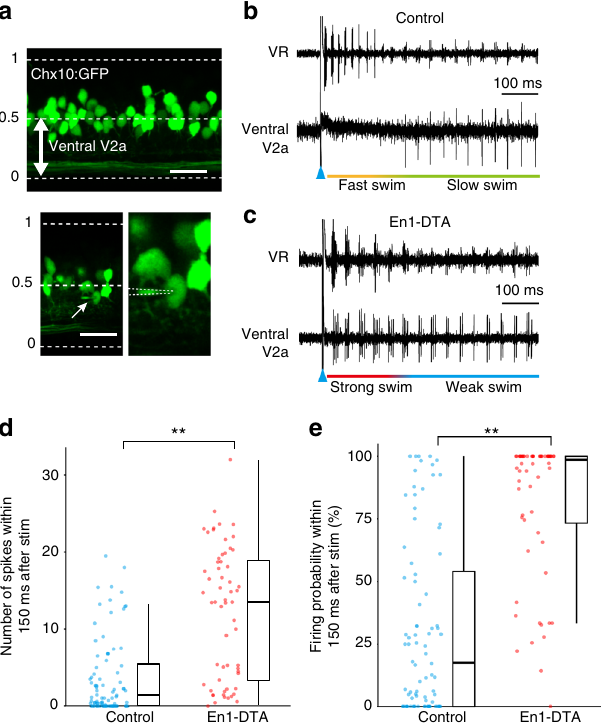
Fig. 5 Activity of ventrally located V2a neurons in control and En1-DTA fi sh. a Lateral view of the spinal cord of Tg[ chx10 :GFP]. The horizontal dashed lines indicate the dorsal and ventral boundaries of the spinal cord. Ventrally located V2a neurons (the position from 0 to 0.5) are the subjects of the recordings (top panel). The bottom two panels show the images of a loose- patch recording. Scale bar, 20 μ m. b An example of simultaneous recordings between ventrally located V2a neurons (loose-patch) and ventral root (VR) in control fi sh. c An example of simultaneous recordings between ventrally located V2a neurons (loose-patch) and VR in En1-DTA fi sh. d , e Numbers of spikes ( d ) and fi ring probability in each cycle ( e ) during fast/strong swim. Each circle represents each cell ( n = 84 for ventrally located V2a neurons in control; n = 60 for ventrally located V2a neurons in En1-DTA). ** P < 0.01 (Mann – Whitney U test, P = 1.3 × 10 − 10 [ d ], P = 3.7 × 10 − 14 [ e ]). Boxes represent the interquartile range (IQR) between fi rst and third quartiles and the line inside represents the median. Whiskers denote the lowest and highest values within 1.5 × IQR from the fi rst and third quartiles, respectively